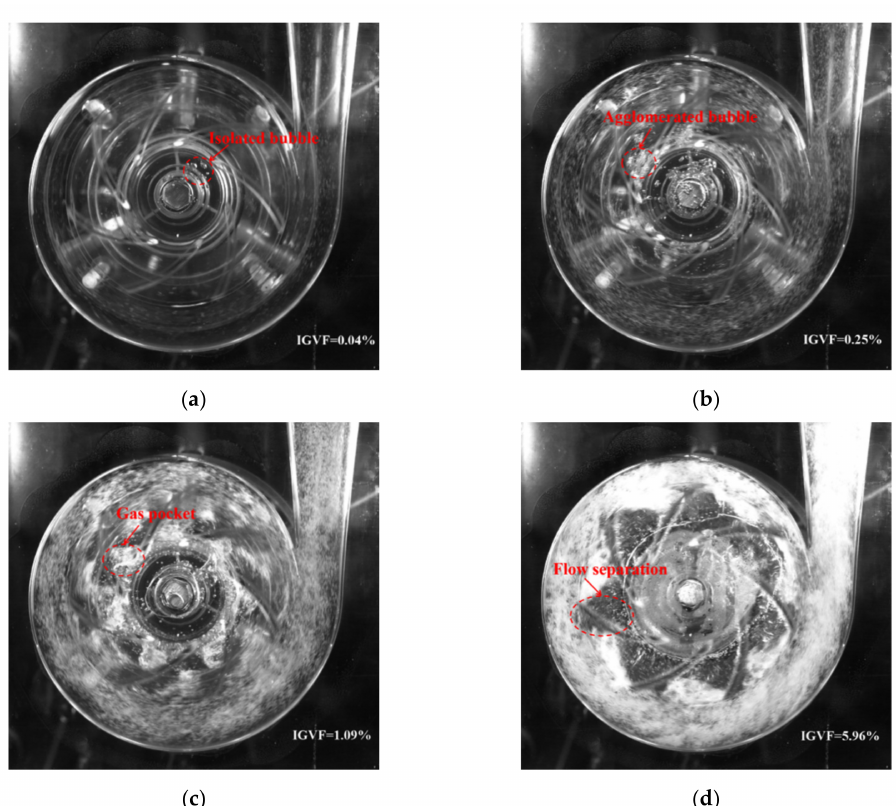
Figure 2. Flow images of four flow patterns in impeller ( N = 1200 rpm, Q L = 5.7 m 3 /h). ( a ) Bubble flow (BF); ( b ) Agglomerated bubble flow (ABF); ( c ) Gas pocket flow (GPF); ( d ) Segregated flow